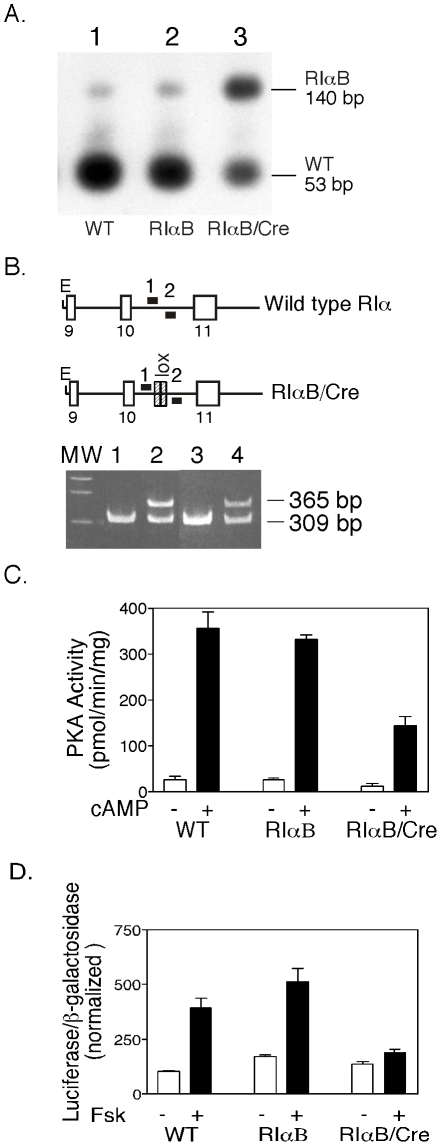
Cre recombinase-mediated activation of the RIαB allele in ES cells decreases PKA activity and forskolin-stimulated CRE-luciferase reporter expression.
A, Transfection of ES cells with a Cre expression vector (pOG231) results in the expression of mutant RNA transcripts. Levels of mutant transcripts were determined by RT-PCR, restriction digestion, and Southern analysis as described in Materials and Methods. The 53 bp fragment indicates WT and the 140 bp fragment indicates mutant RIα transcripts. The small upper band present in lane 1 (WT) is due to incomplete digestion with BstN1, and was subtracted from lane 2 (RIαB) to determine the level of mutant RNA in these cells (<2%). The level of mutant transcript in RIαB/Cre ES cells is ∼49%. B, Detection of Cre-mediated recombination events in RIαB/Cre ES cells was determined by PCR using primers 1 and 2 (as shown in the figure) to amplify across the specified regions. Lane 1 is a WT control, Lane 2 is positive control for recombination. Lane 3 represents RIαB ES cells, which contain a single band due to presence of single WT RIα allele (the PCR conditions did not allow amplification through the floxed-neor cassette). Lane 4 represents RIαB/Cre ES cells, which contain a recombined allele (356 bp) and WT allele (309 bp). C, Kinase assay of basal and total activity in WT, RIαB, and RIαB/Cre ES cells. All samples were done in triplicate in the absence (basal PKA activity) or presence of 5 µΜ cAMP (total PKA activity) using Kemptide as substrate. Kinase activity that was not PKA-specific was measured in the presence of PKI and subtracted from basal and total values. Data values are represented as mean ± SEM. D, Representative CRE-luciferase assay. WT, RIαB, and RIαB/Cre ES cell lines were transfected with the CRE-dependent α168-luciferase reporter and then stimulated with forskolin (10 uM) for 14 h before an assay for luciferase activity as described in Materials and Methods. Transfections were done in triplicate.